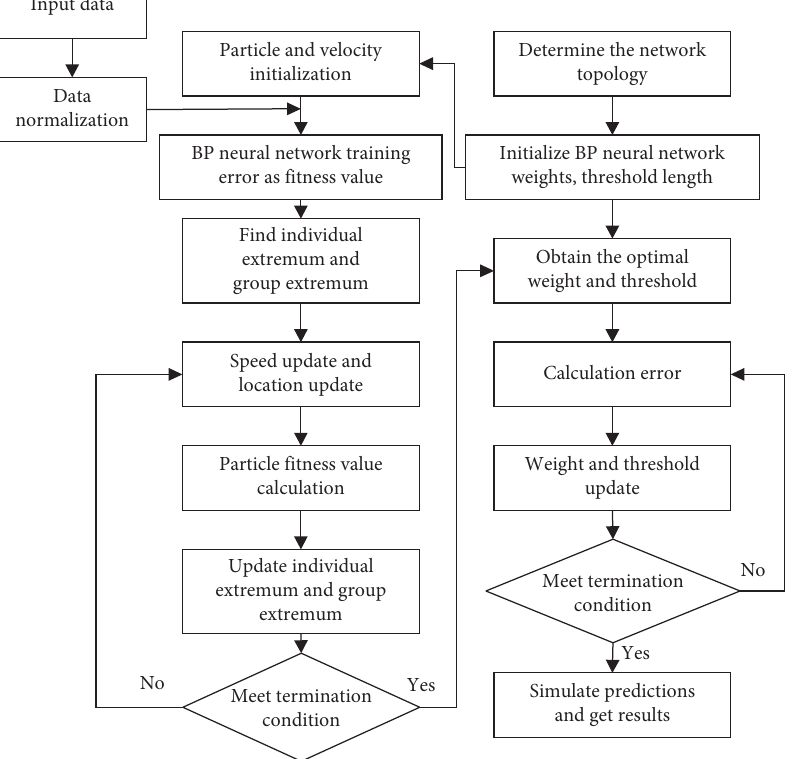
Figure 3: PSO-BP neural network